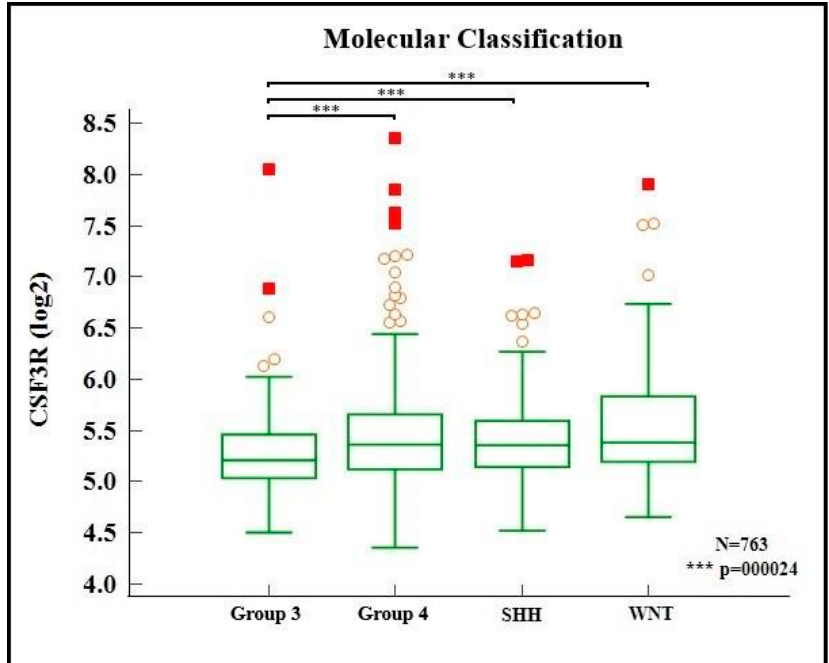
Figure 2. CSF3R expression in medulloblastoma molecular groups. Red circles and squares represent, respectively, outside and far out values (larger than the upper quartile plus 1.5 and 3 times the interquartile range, respectively). Source: the authors. Compiled using MedCalc ® version 20.115 (MedCalc Software Ltd., Ostend, Belgium).